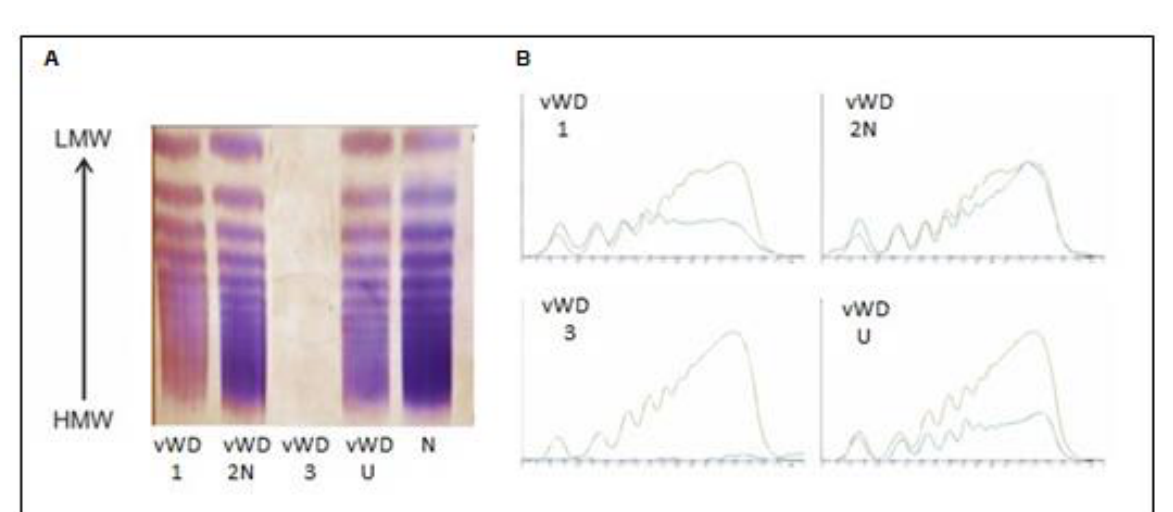
Figure 3. Analysis of VWF multimers of patients with VWD type 1 (sample number 1 in Table 1), VWD type 2N (sample number 2 in Table 1), VWD type 3 (sample number 3 in Table 1), and VWD U (unclassified) (sample number 4 in Table 1); ( A ) semi-automatic Hydrasys 2 scan and ( B ) densitometric evaluation. Table 1. Results for patients with VWD type 1, VWD type 2N, VWD type 3, and VWD U (unclassified).